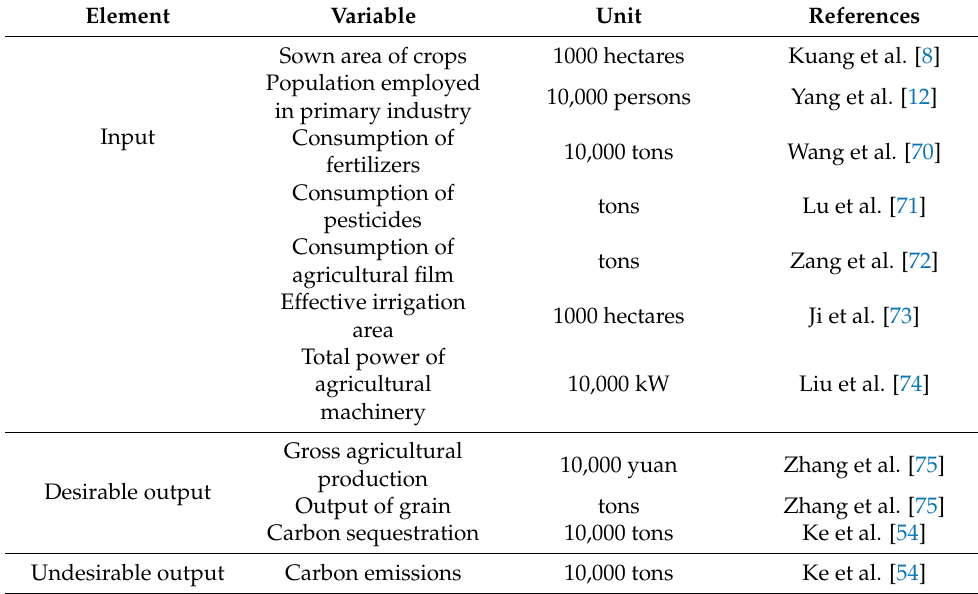
Table 2. Input and output variables for measuring the